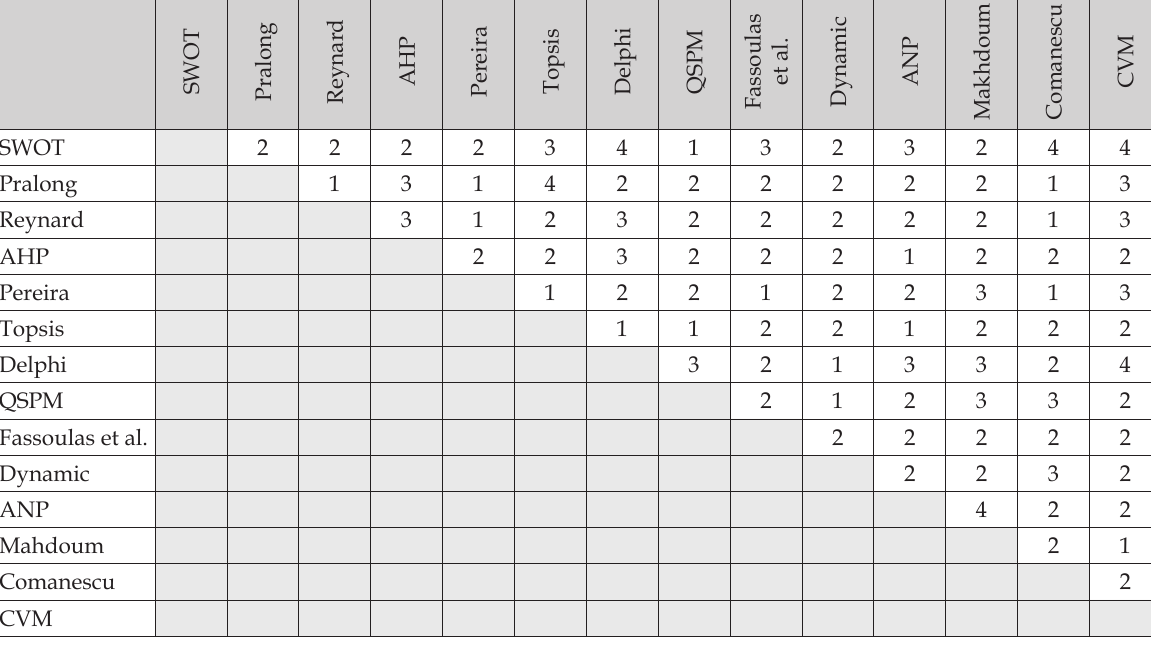
Table 5. The pairwise comparison matrix chart for ‘Easy Measurement’ criterion in the expert choice software